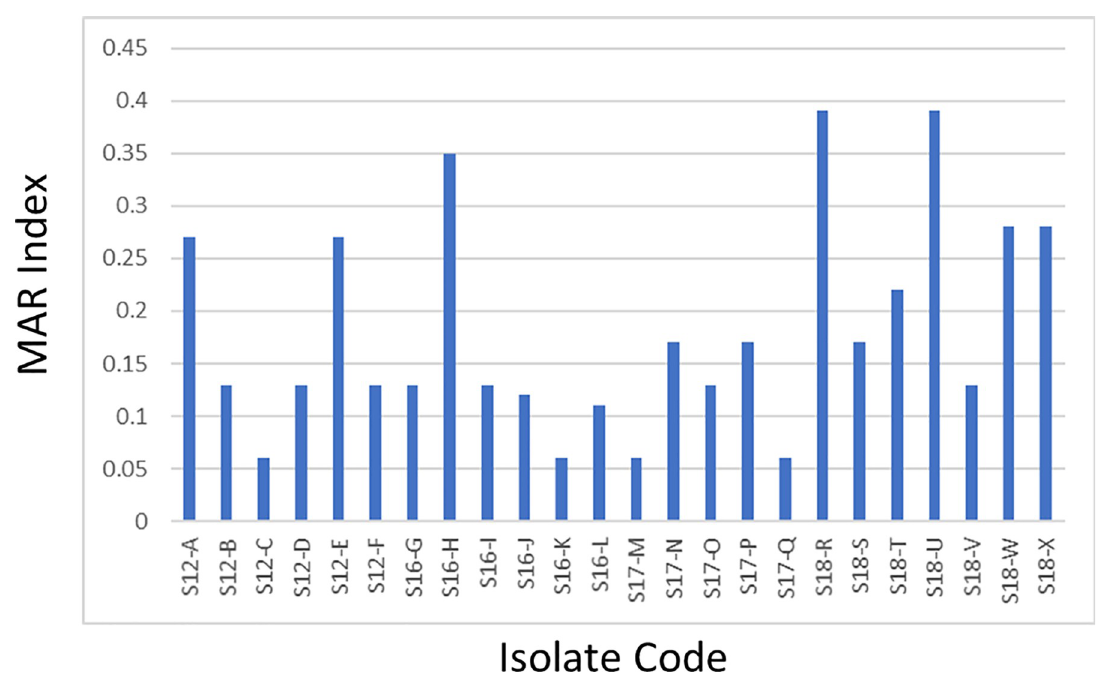
Fig 3. MAR index values of Enterobacteriaceae from sampled